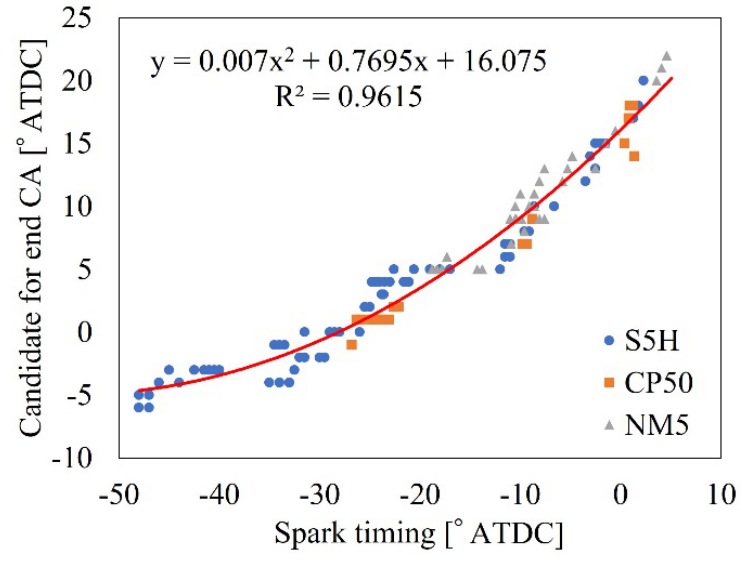
Figure 9. Relationship between spark timing and the candidate for the end CA, and the approximation formula.